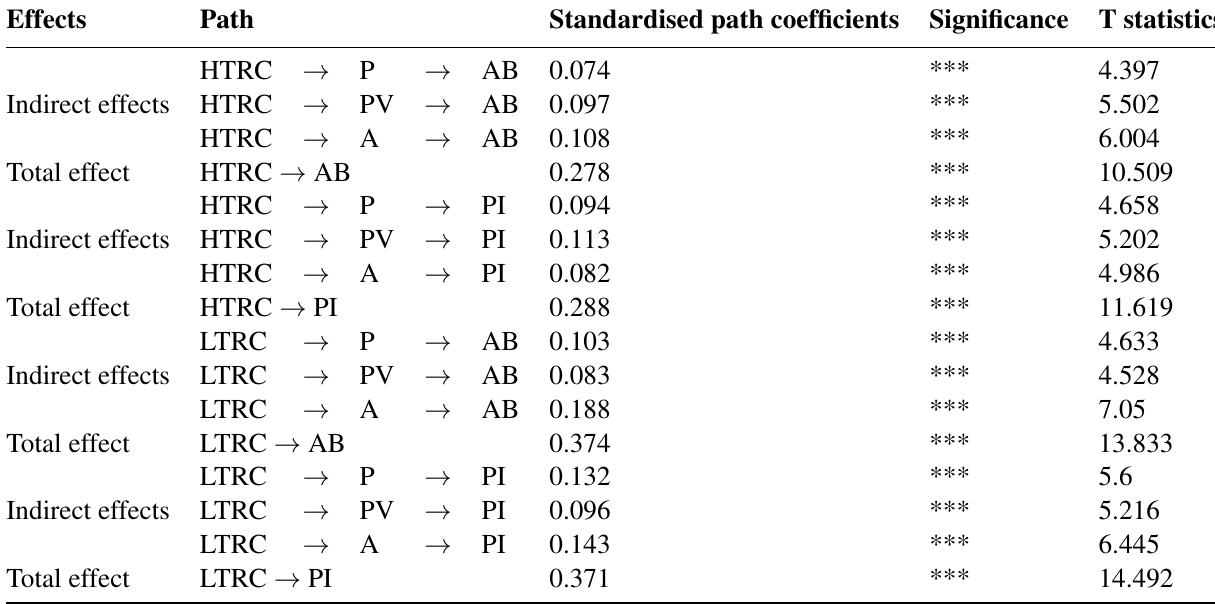
Table 6 Indirect effects of HTRC and LTRC on